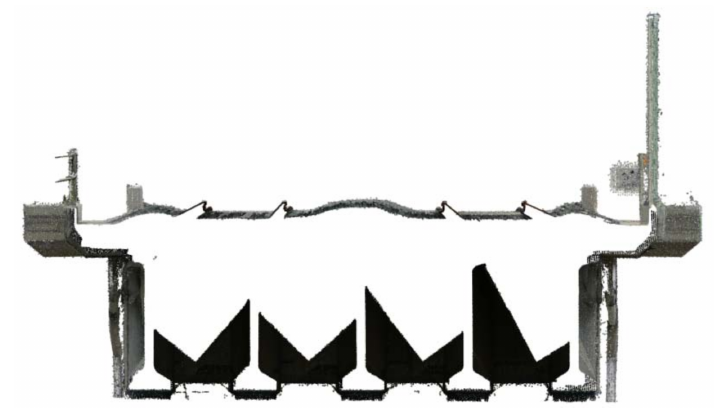
Figure 22. Front view (X-Z plane) of point cloud data for Osong test track fifth bridge.